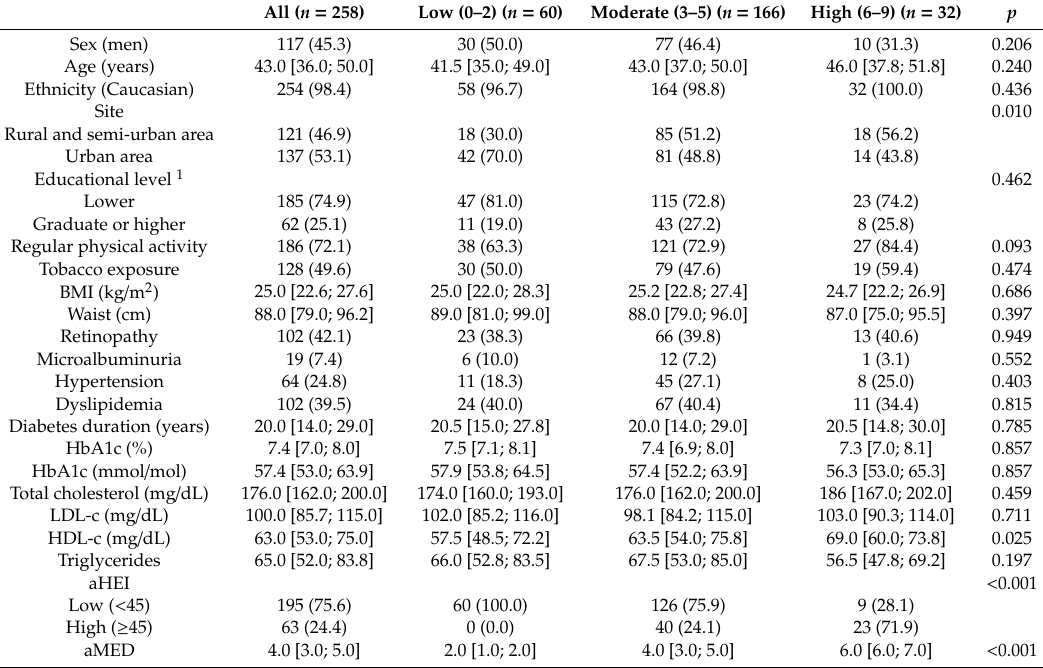
Table 1. Descriptive analysis of the characteristics of the study participants according to the alternate Mediterranean Diet